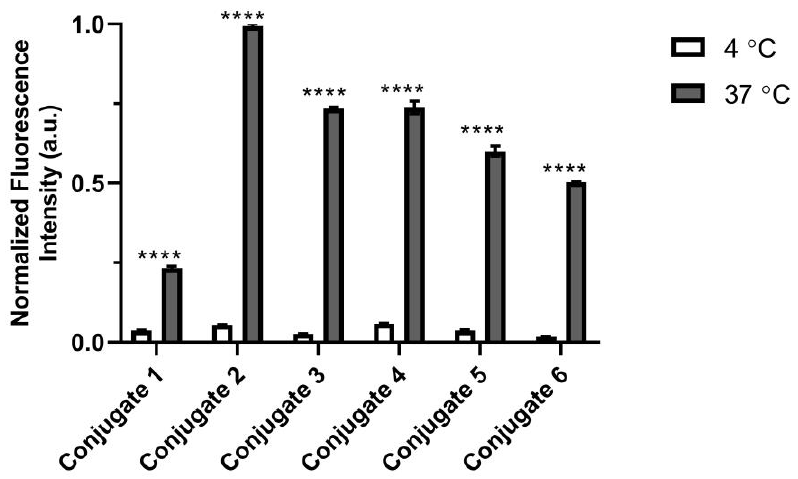
Figure 6. Internalization of steroid-BODIPY conjugates 1 – 6 in PC-3 cells at 4 ◦ C or 37 ◦ C over 6 h. PC-3 cells were seeded for 24 h in complete RPMI medium, and then the medium was replaced with RPMI without phenol red and with 50 µ M of estradiol derivates ( 1 and 2 ) or androgen derivates ( 3 – 6 ), incubated at 4 ◦ C or 37 ◦ C. After 6 h of incubation, the cells were visualized using an inverted microscope, and images were acquired for the quantification of the fluorescence intensity. The fluorescence intensity of the cells was corrected for background fluorescence and normalized with vehicle (DMSO). Results are expressed as the mean ± SEM of two independent experiments. The statistical significance was evaluated by the two-way ANOVA method (**** p ≤ 0.0001).